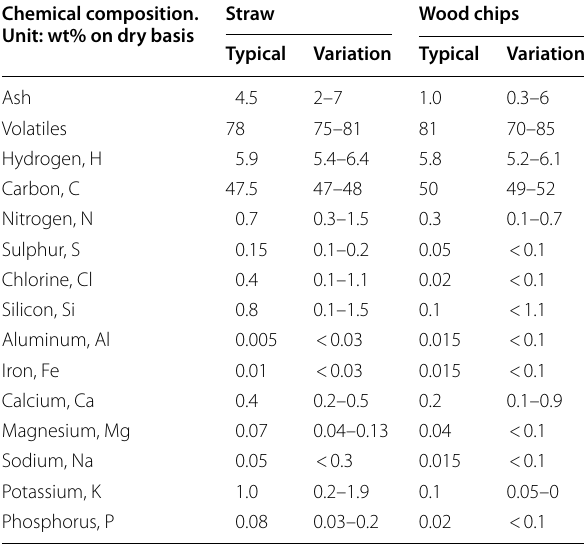
Table2 Fuel data for Danish cereal straw and wood chips [20] Chemical composition. Unit: wt% on dry